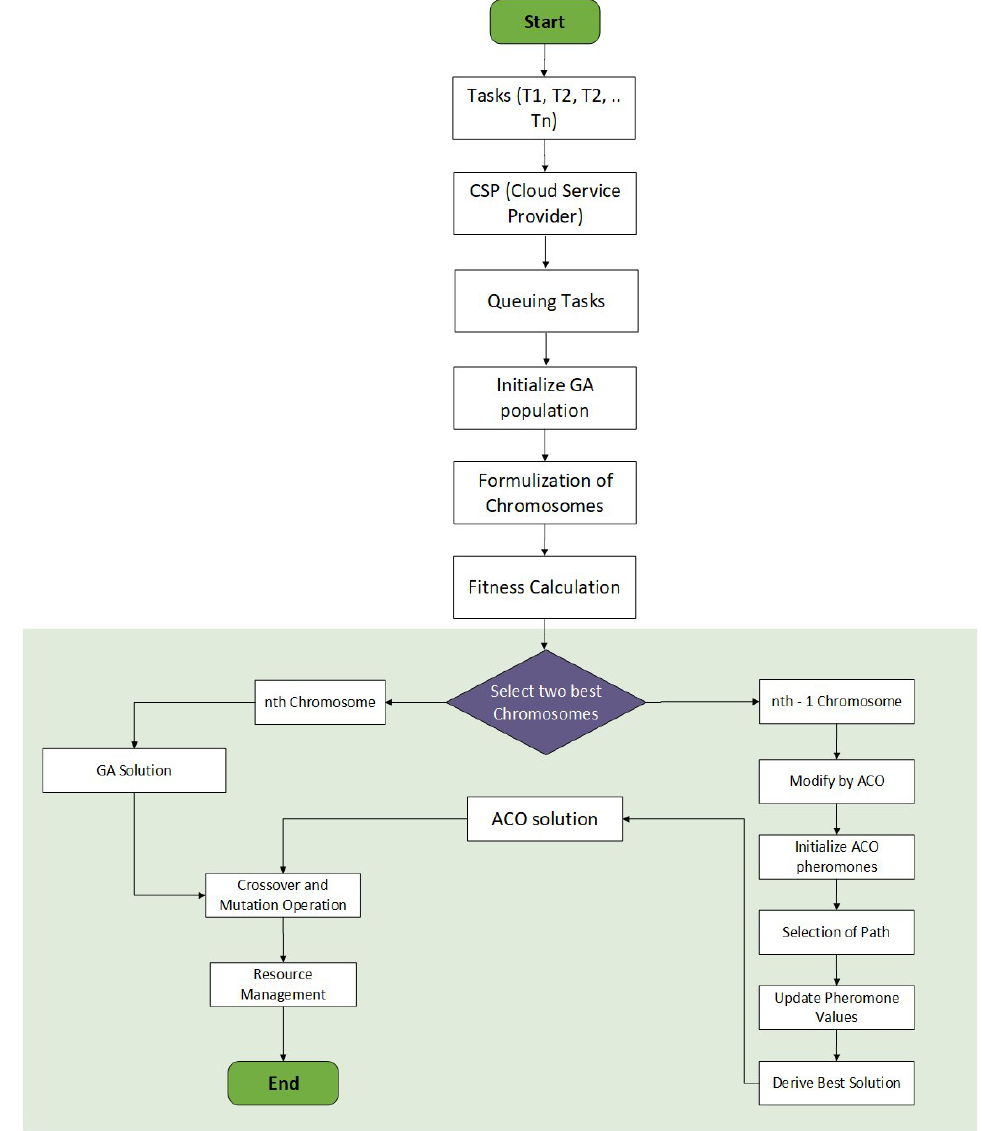
Figure 2. Flow chart of proposed ALTS